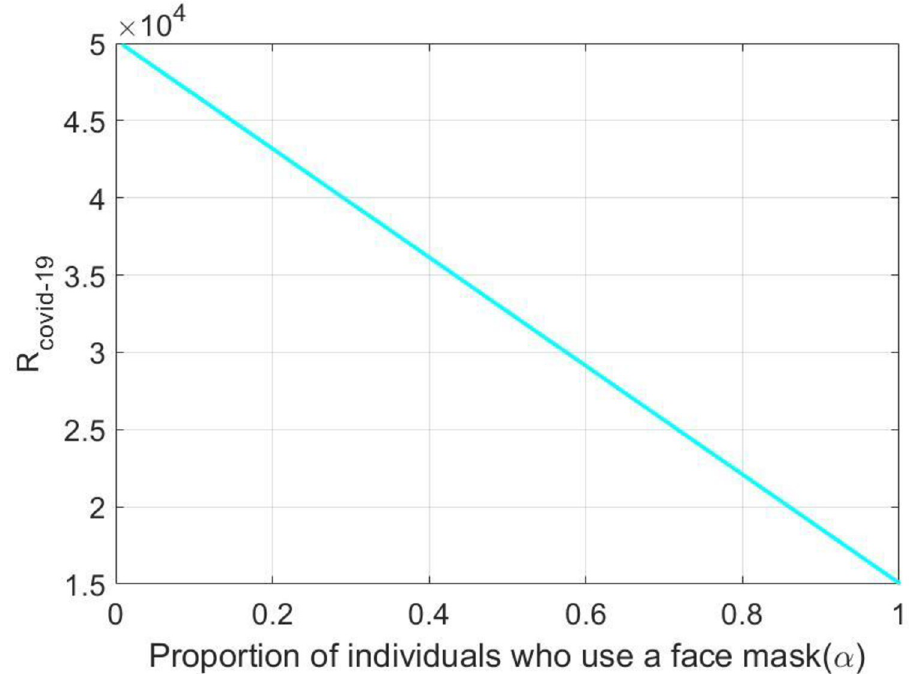
Fig 4. Variation of R Covid 19 under α .